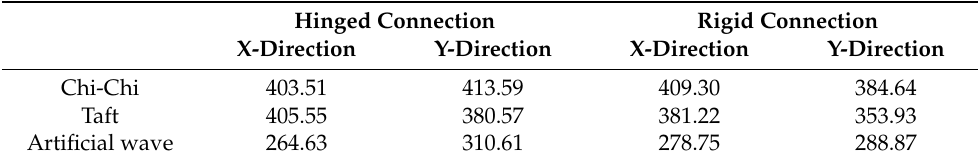
Table 12. Peak acceleration under the action of rare earthquakes (cm/s 2